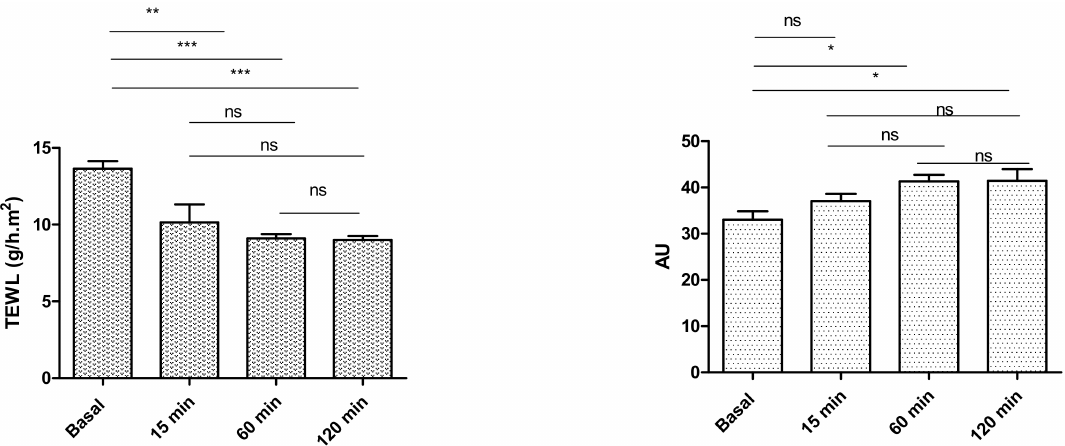
Figure 9. Biomechanical parameters evolution monitored before the application of the formulations and 1 h after application. TEWL is expressed as g/h cm 2 and the SCH as arbitrary units (AU). Significant statistical differences: * p < 0.05, ** p < 0.01, *** p < 0.001, ns = non-significant.